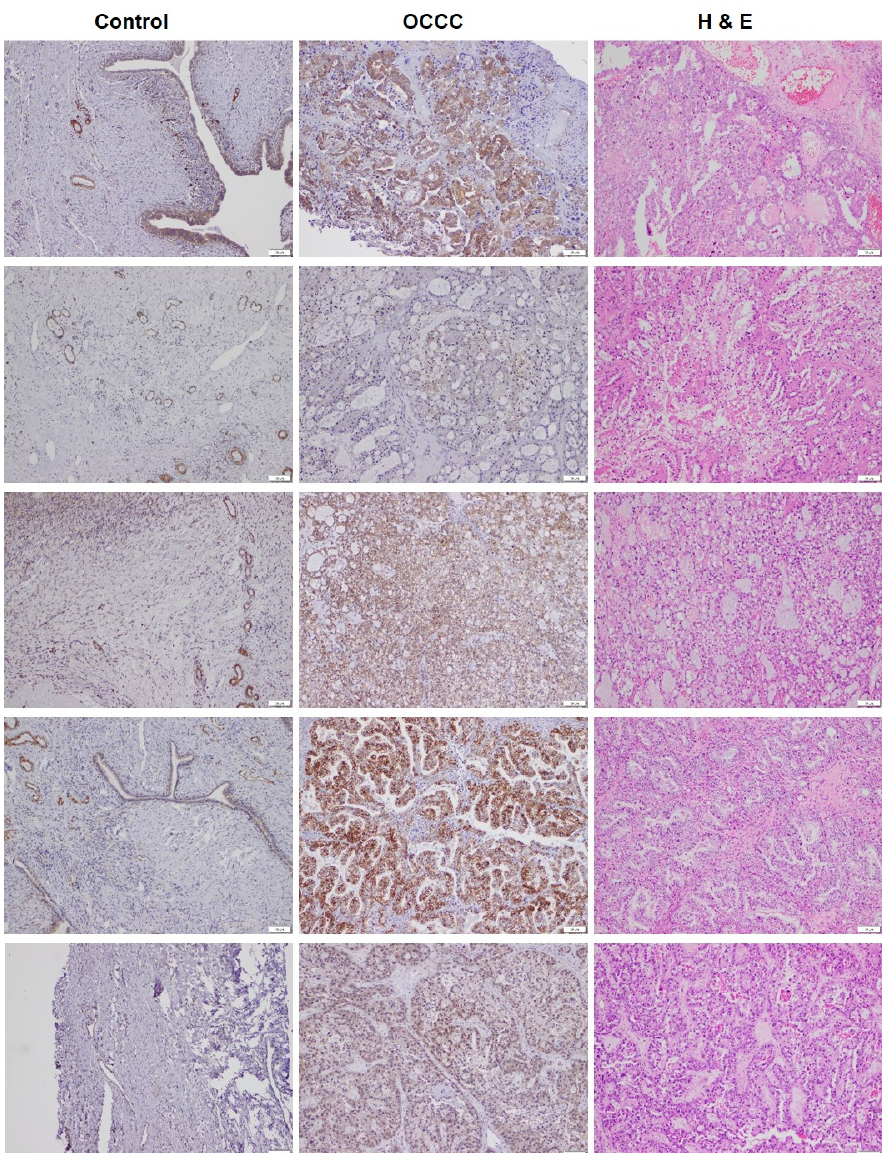
Figure 4. Immunohistochemical staining of SCD was carried out on tissue sections from OCCC and corresponding control ovarian tissue ( n = 5 each, all sections are depicted at the same optical magnification, scale bar = 50 µm). There was increased expression of SCD in OCCC.